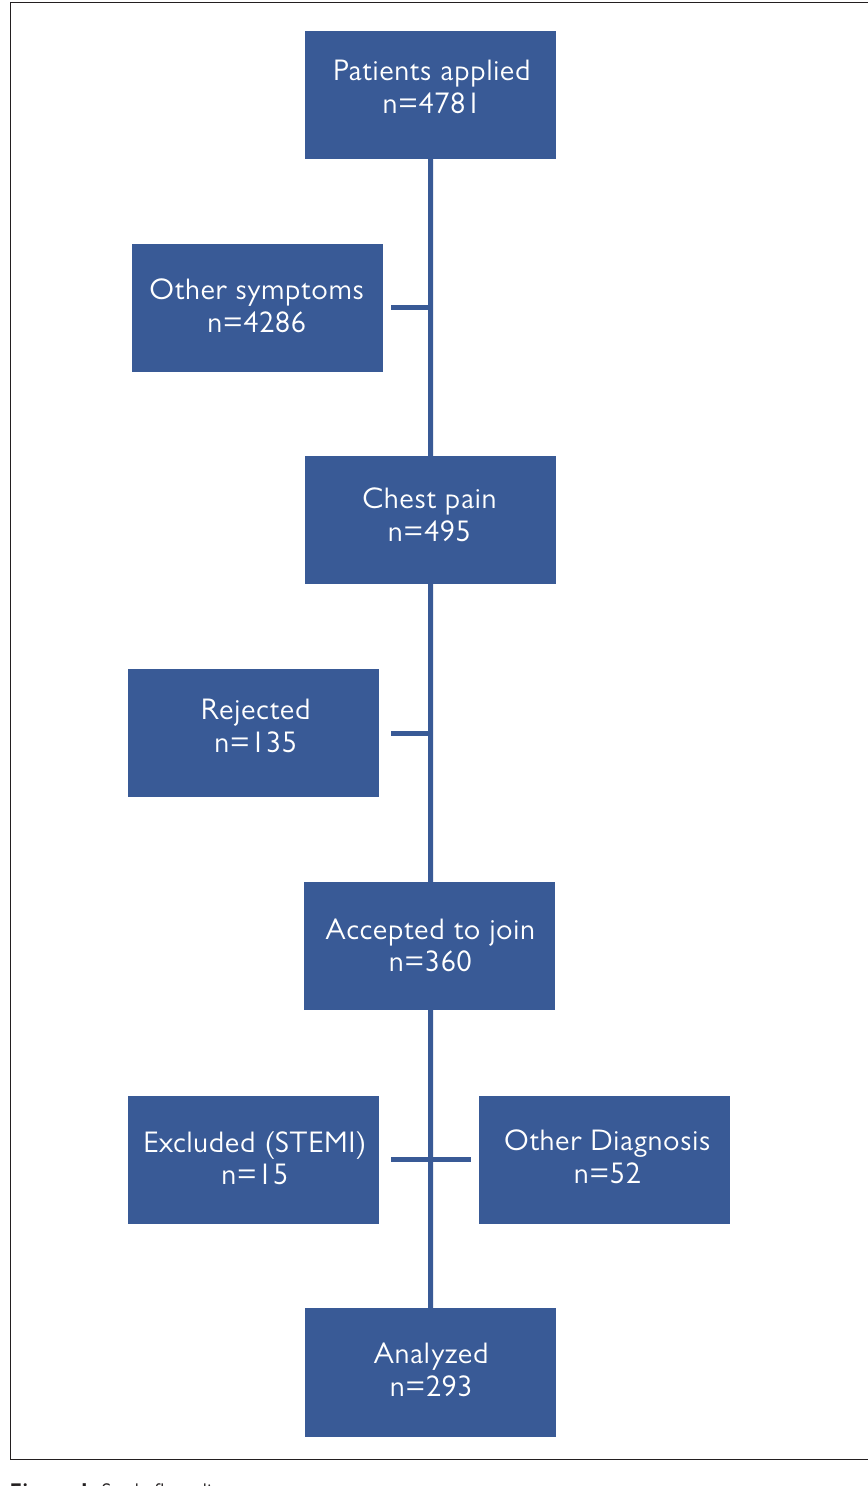
Figure 1. Study flow